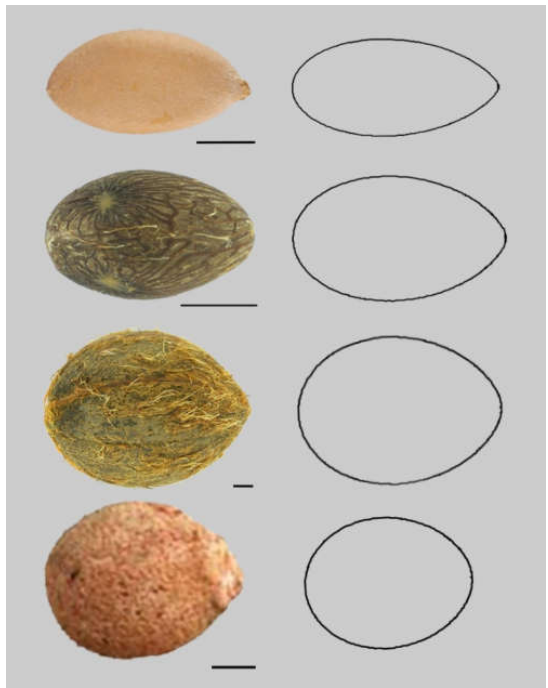
Figure 7. An example of the superellipse (model) and representative seeds adjusting to models in this family (between parentheses the values of J index with this model): P. canariensis (92.15 is the mean value of 25 seeds), Welfia regia (92.6), and Raphia taedigera (90.0). Bars represent 0.5 cm. The model is defined by Equation (6) with  = 3.6,  = 2.2, and  = 2.4.